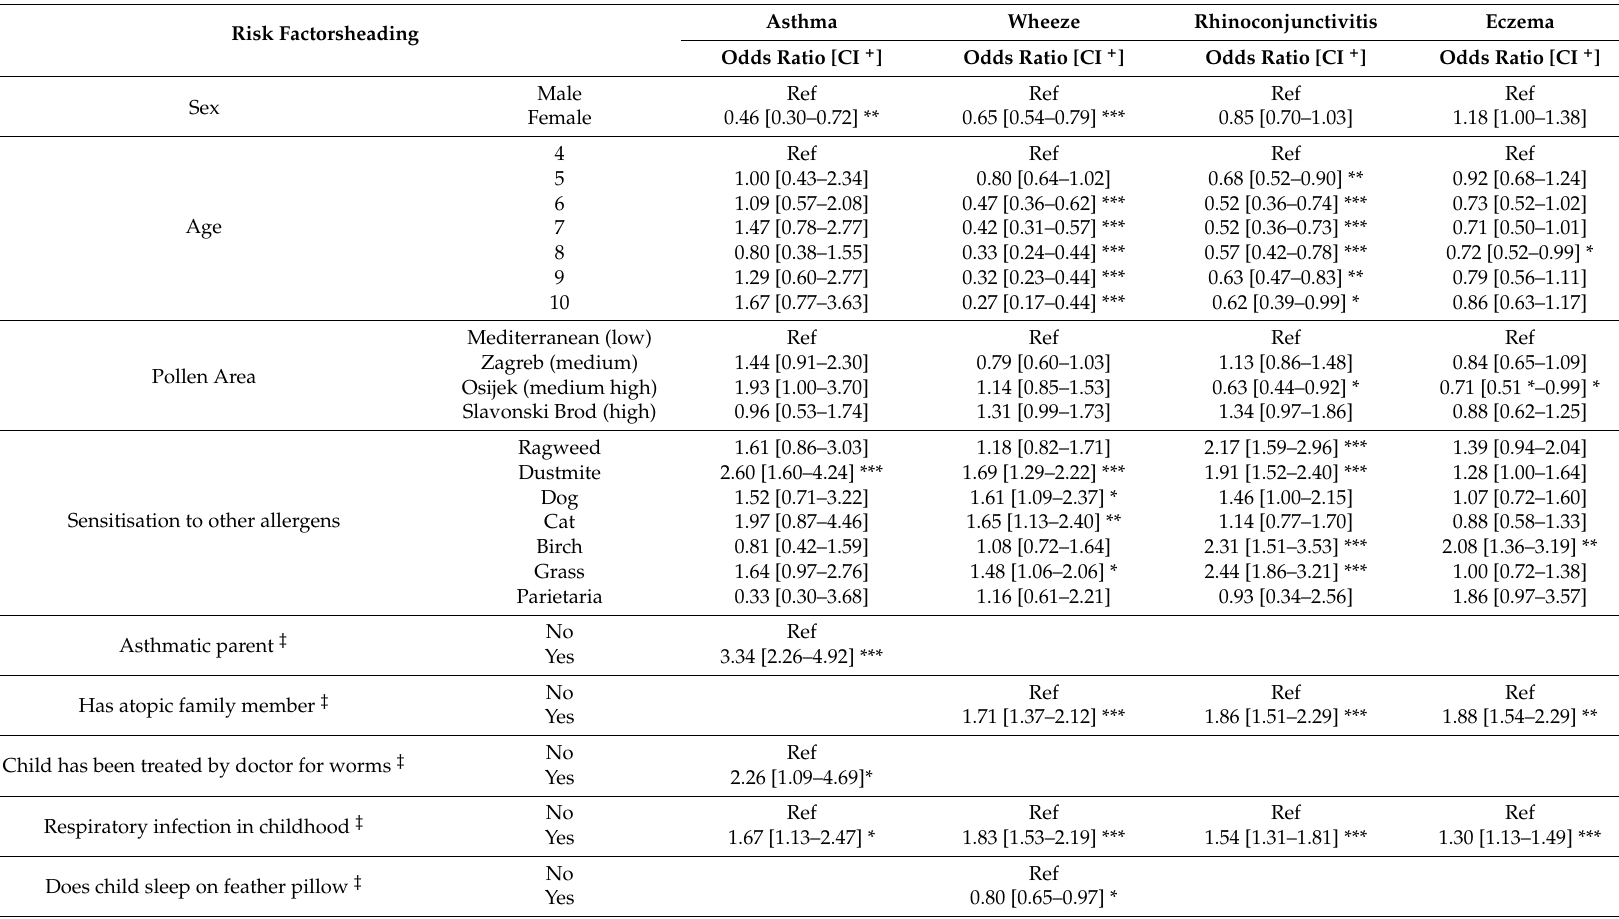
Table 4. Factors associated with the development of allergic disease in